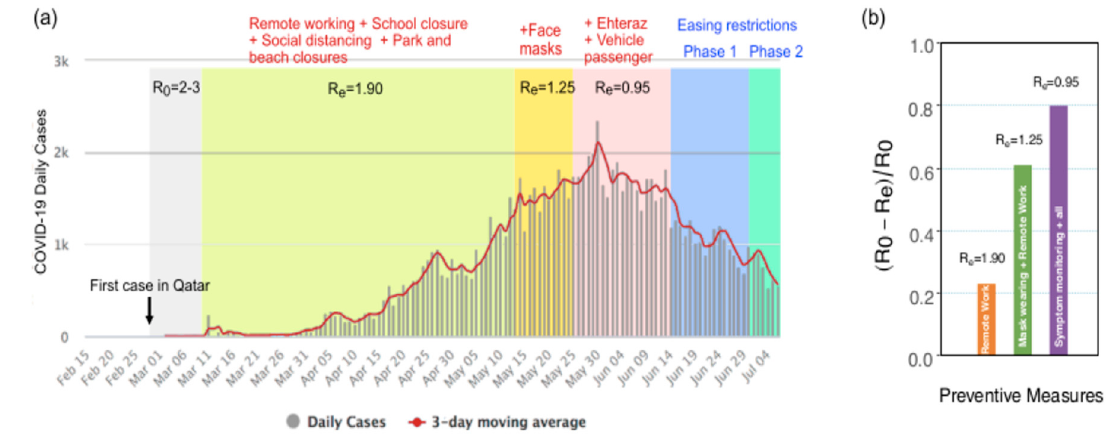
Figure 7. ( a ) A graph summarizing the real infection data with our estimated R 0 and R e mapped onto phases of intervention measures taken by state of Qatar. ( b ) Relative effectiveness comparisons. The relative effectiveness varies as the effectiveness is quantified as ( R 0 − R e / R 0 ). The early preventive measures (remote working + school closure + social distancing + park/beach closure) reduced R e by > 20%. In addition, the additional imposition of nation-wide mask-wearing reduced it further by > 60%. Furthermore, a >81% reduction was attained with the mandatory introduction of the GPS-Bluetooth-based contact-tracing application (Ehteraz) for all the residents on their smartphones.